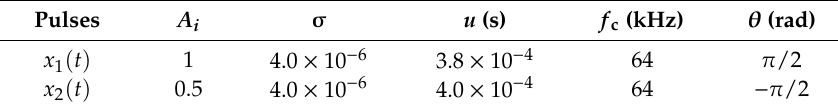
Table 2. Parameters of Gabor pulses x 1 ( t ) and x 2 ( t )